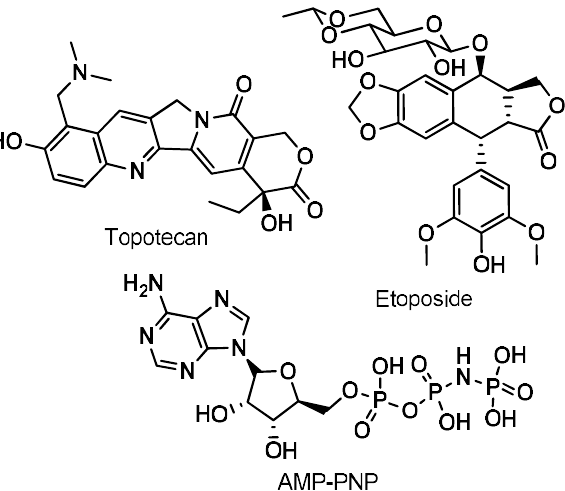
Figure 4. Structures of the co-crystallized inhibitors with the DNA-binding domain of topoisomerase I (topotecan) and topoisomerase IIα and IIβ (etoposide) as well as with the ATPase domain of topoisomerase IIα (AMP-PNP).